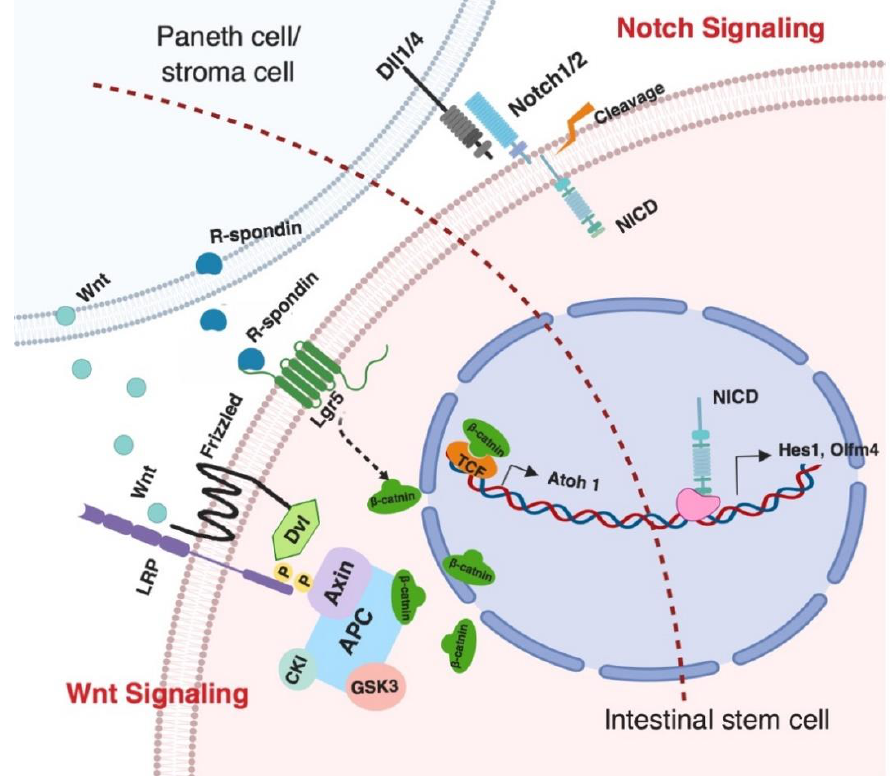
Figure 2. Notch and Wnt signaling pathways. The di ff erentiation of intestinal stem cells is mainly controlled by Notch and Wnt signaling pathways. The neighboring cells, including Paneth or stromal cells, provide Wnt proteins and R-spondins for activating Wnt signaling, and Notch ligands Dll1 / 4 for inhibiting Notch signaling. The canonical Wnt signaling is activated by the binding of Wnt protein binding to the LRP (Low density lipoprotein receptor-related protein) / Frizzled receptor complex to initiate the dissociation of intracellular APC complex and cause the release of β -catenin, which binds the transcriptional factor TCF and activates the expression of Atoh1 that controls intestinal stem cell di ff erentiation. Lgr5 is an intestinal stem cell marker and an R-spondin ligand. The activation of Lgr5 also promotes the accumulation of β -catenin and causes the downstream activation [43]. Notch signaling is controlled by interactions of Notch and Dll1 / 4. The dissociation causes the cleavage of Notch receptor to release the NICD (notch intra-cellular domain), which is able to interact with other transcriptional factors to initiate the expression of Hes1 or Olfm4 for regulating stem cell di ff erentiation in intestine [34].